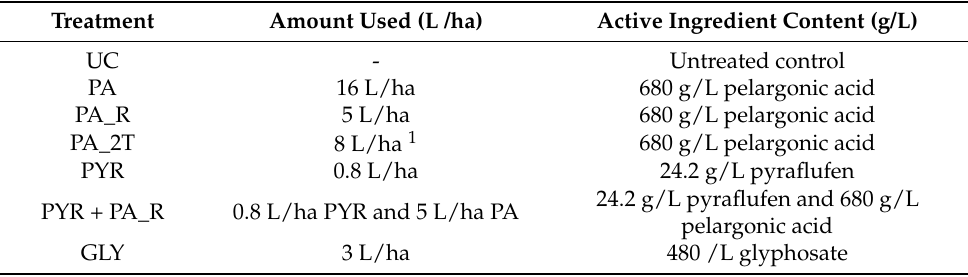
Table 1. Herbicide treatments used in the experiments in 2019 and